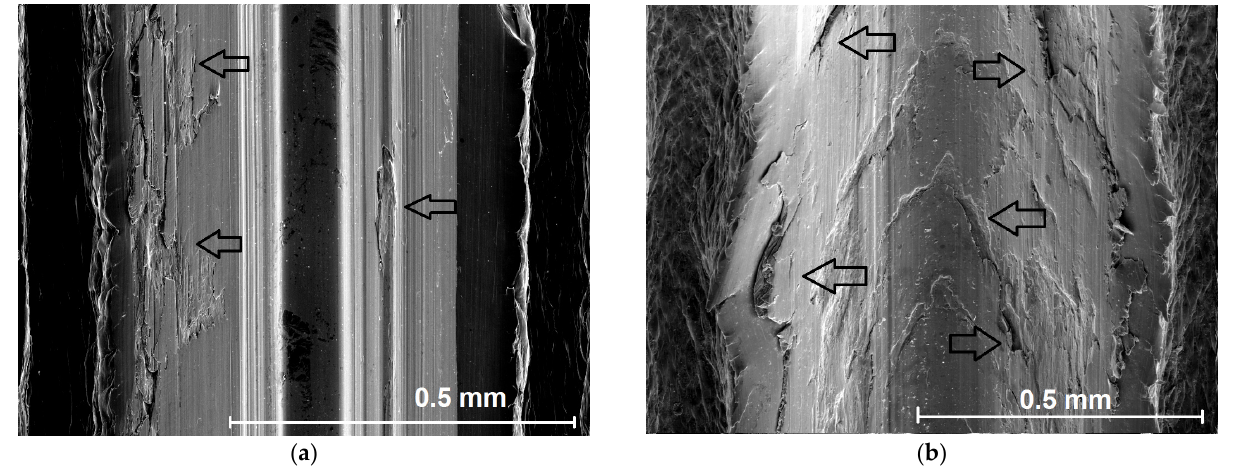
Figure 13. Surface quality of the threads: ( a ) planar defects—for the coefficients of friction around 0.3–0.4, ( b ) bulk defects, abortion of the thread profile (for coefficients of friction equal to or higher than 0.5).